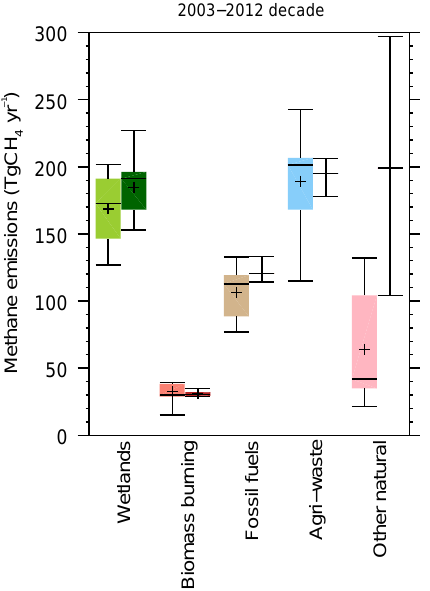
Figure 5. Methane global emissions from the five broad cate- gories (see Sect. 2.3) for the 2003–2012 decade for top-down in- versions models (left light-coloured boxplots) in TgCH 4 yr − 1 and for bottom-up models and inventories (right dark-coloured box- plots). Median value, and first and third quartiles are presented in the boxes. The whiskers represent the minimum and maximum val- ues when suspected outliers are removed (see Sect. 2.2). Suspected outliers are marked with stars when existing. Bottom-up quartiles are not available for bottom-up estimates. Mean values are repre- sented with “ + ” symbols; these are the values reported in Table